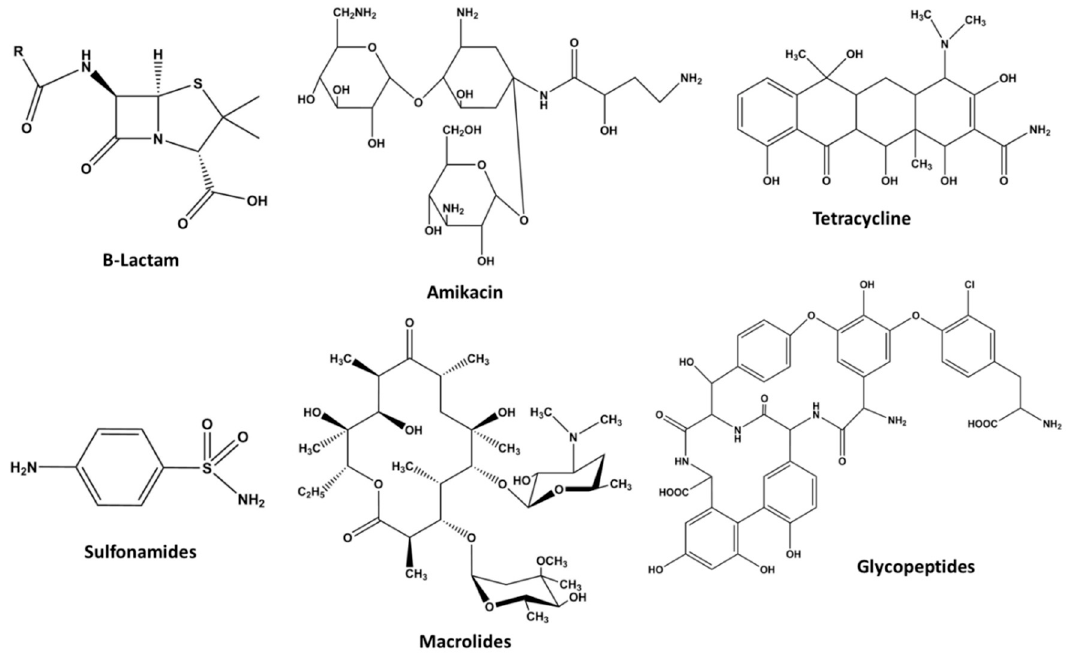
Figure 5. Common structure of some major antibiotic classes.